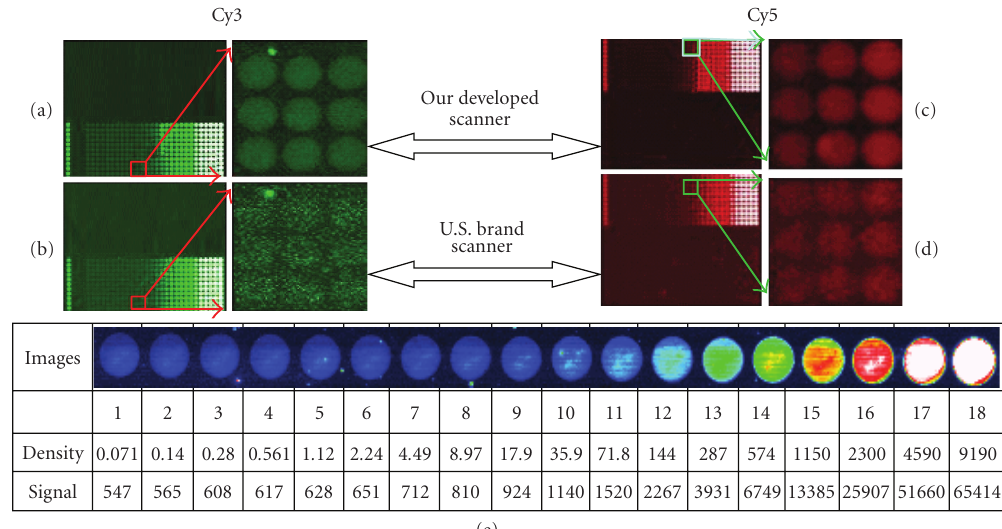
Figure 7: The analysis features of the newly developed confocal